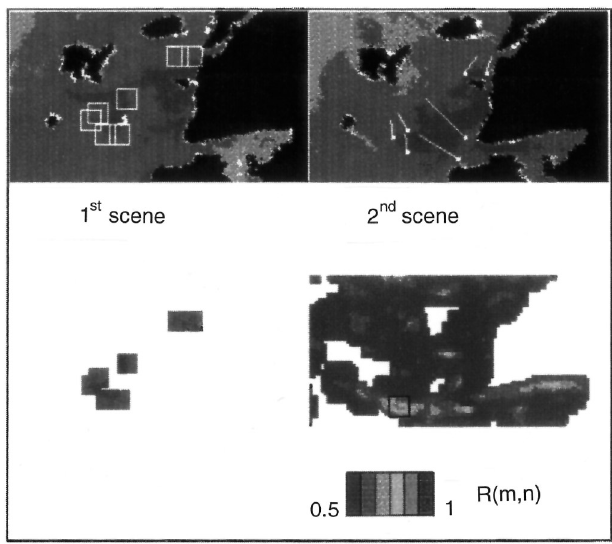
Fig. 3. Visual example of MCC method. Several windows are fixed in the first scene, while in the 2nd one the windows move within a search area. Pattern of the correlation ( R ( m , n )) in the search area of the 2nd scene correlated with the window of the first scene. The maximum R ( m , n ) displacement between two sequential images is used for advectional current vectors